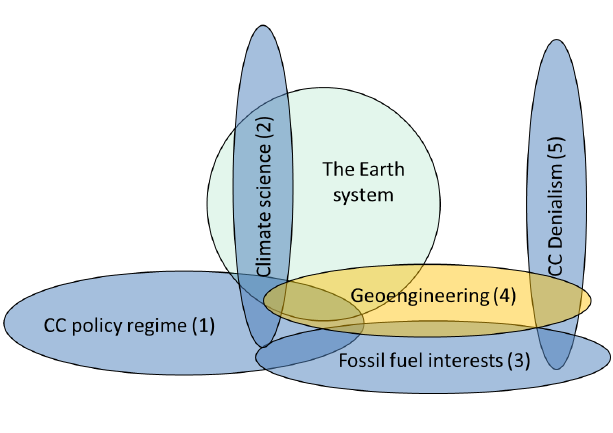
Fig. 2 . Schematic picture of how strategic action fields are linked and may interact with the Earth system. Numbers refer to Table